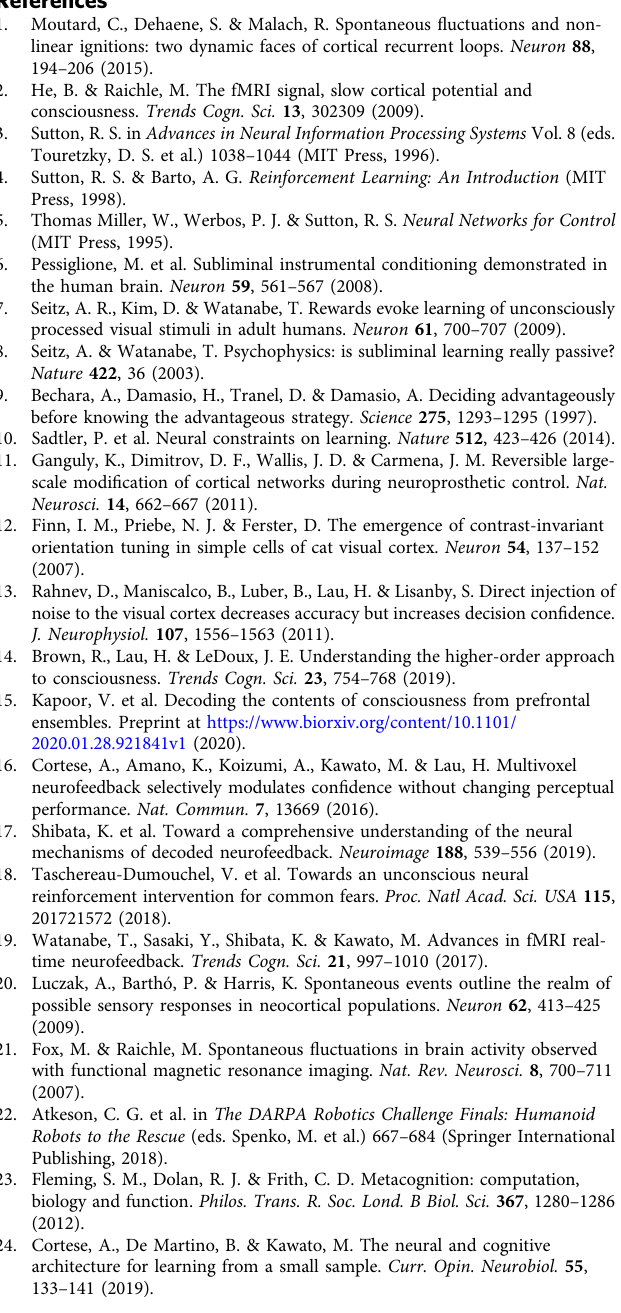
FIG_6A_data.mat, CHI_pconf_prpe.mat. A reporting summary for this Article is available as a Supplementary Information fi